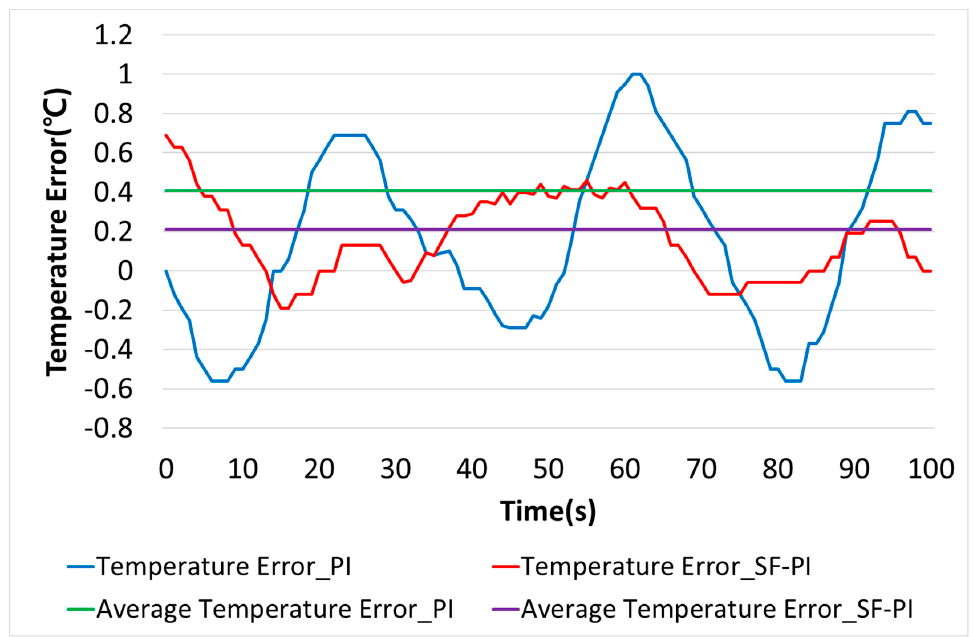
Figure 19. Temperature error comparison for changing temperature and humidity. Table 10. Comparison of average temperature error about changing temperature and humidity.